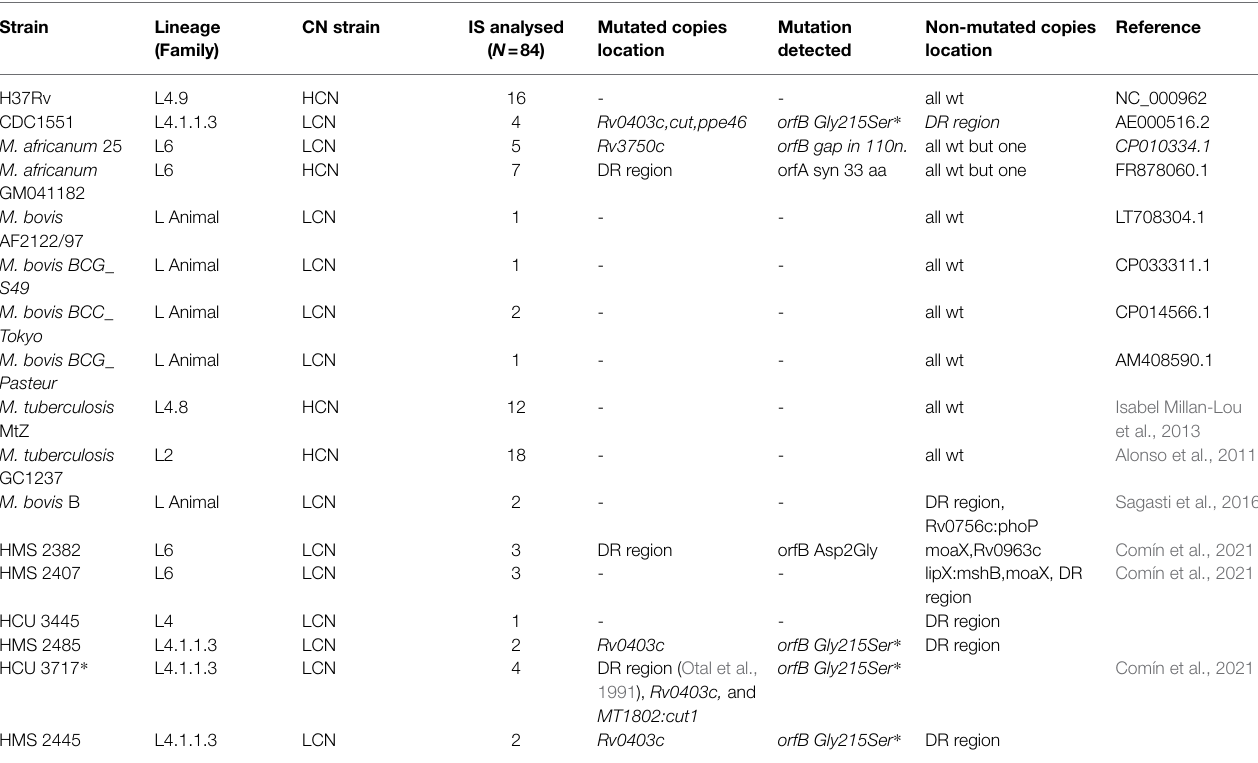
TABLE 1 | Summary of IS 6110 copies analysed in the strains for which the location of all the IS copies within their genomes is known, detailing the IS copies mutated by comparison with the reference IS in Mycobacterium tuberculosis H37Rv.